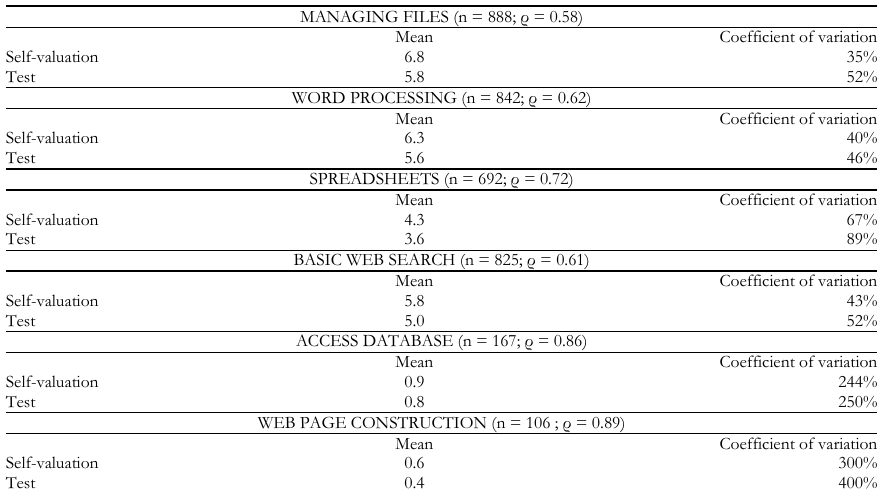
Results obtained for self-valuation and test in the six applications considered MANAGING FILES (n = 888; ρ = 0.58)